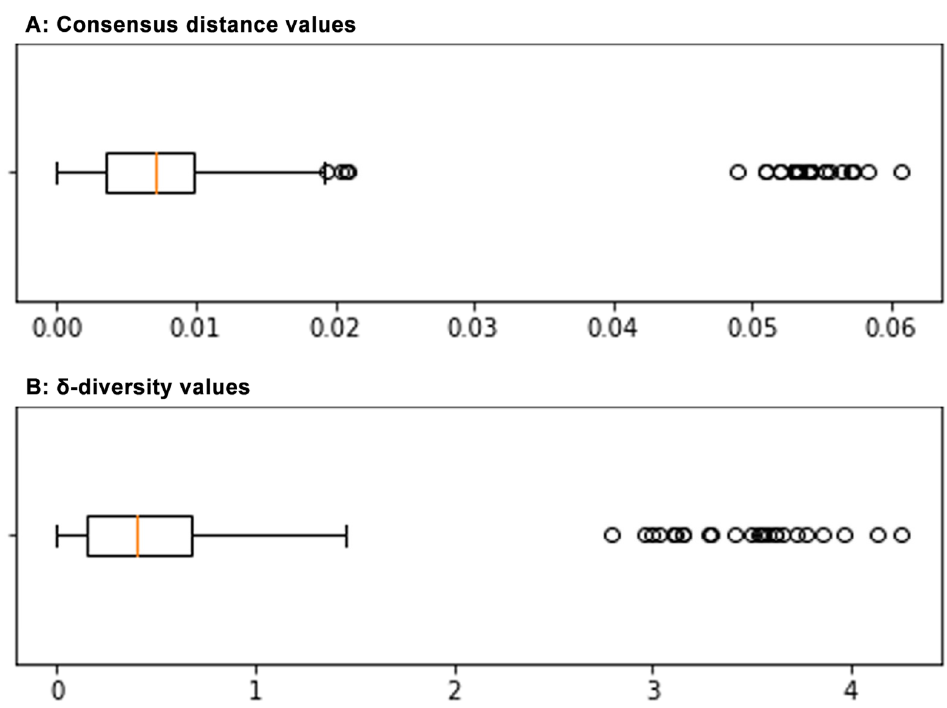
Figure 4. Boxplot graph of the distribution of consensus distance values ( A ) and of δ -diversity values ( B ) in the sample set. For both, average, 25–75% interquartile range, SD interval and single high-range outlier values are shown. Average δ -diversity value is termed as ‘ σ -diversity’ index.